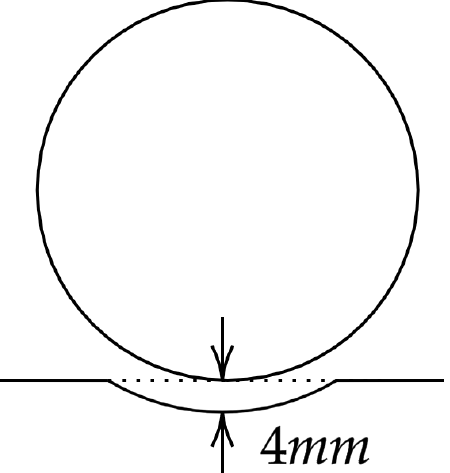
Figure 4. Illustration of the machined wheel pads preventing contact between the live model and grounded